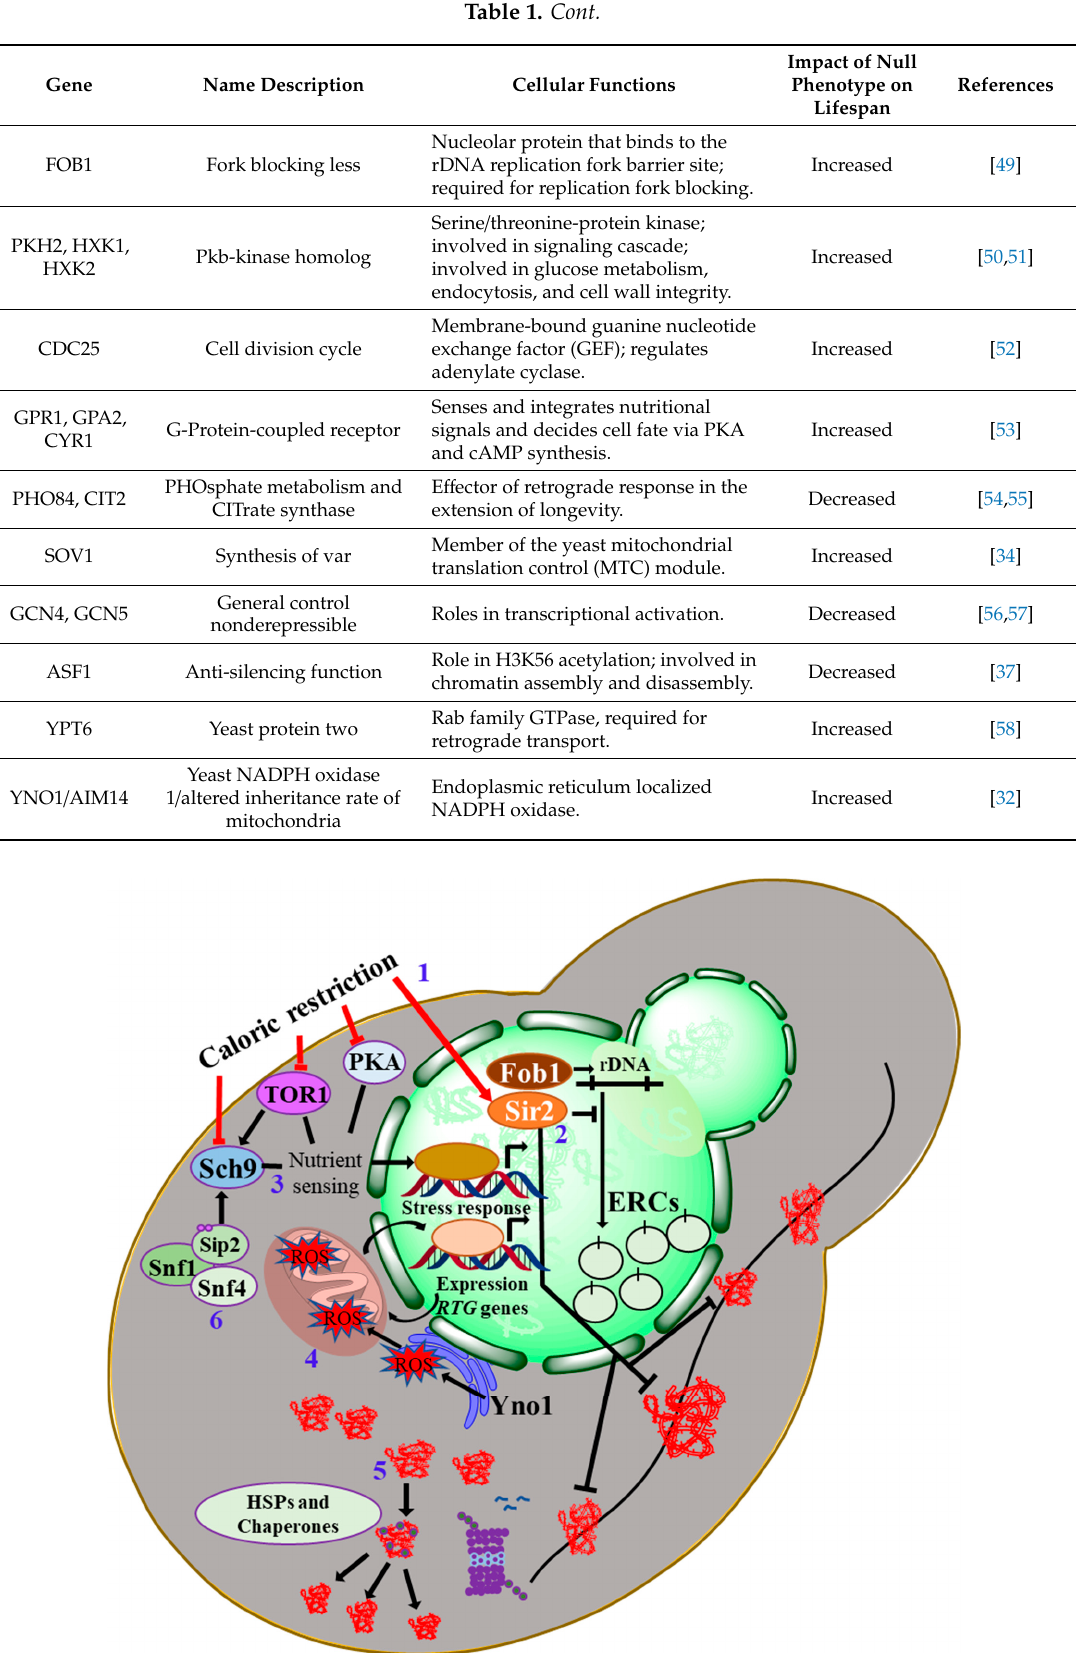
Figure 2. Pathways modulating the yeast lifecycle. Illustration of the major pathways that